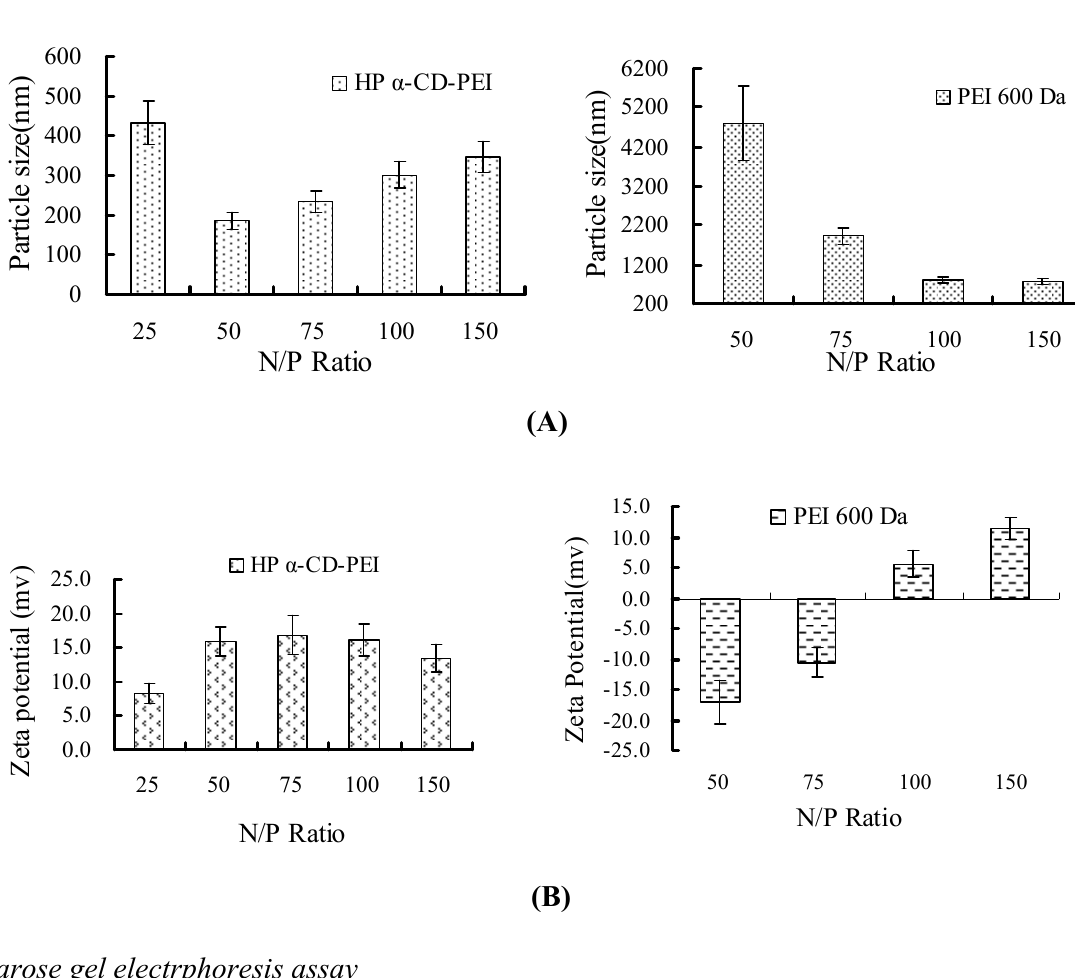
Figure 2. (A) Particle size (B) Zeta potential of HP α -CD-PEI/DNA and PEI 600 Da/DNA complexes.